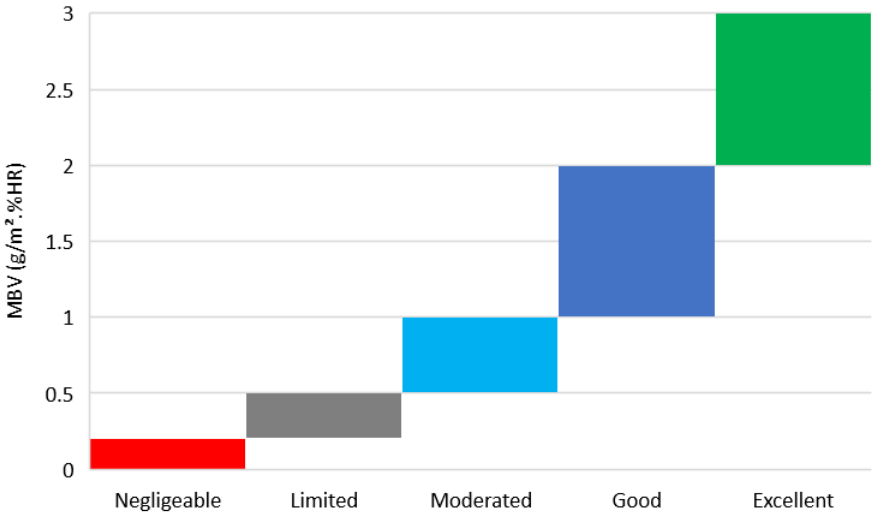
Figure 3. Nordtest project classification of materials versus Moisture Buffer